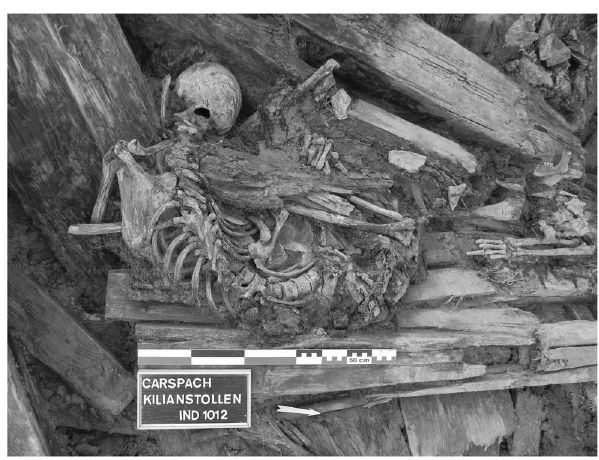
Figure 1. The soldiers recovered during the excavations of ‘‘Kilianstollen’’ in Carspach. A- Soldier # 1012. B- Soldiers # 1018 (left) and # 1019 (right) (Photo: M. Landolt).